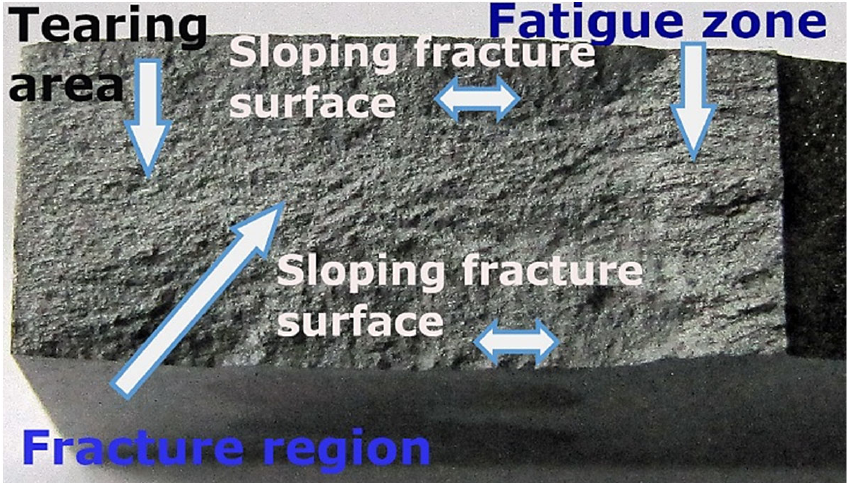
Figure 5. Damage zones of the 44200 aluminium alloy composite with 15% Al 2 O 3 reinforcement (Saffil fibres) captured in the fatigue pre-cracking and monotonic tensile stages of the fracture toughness test.